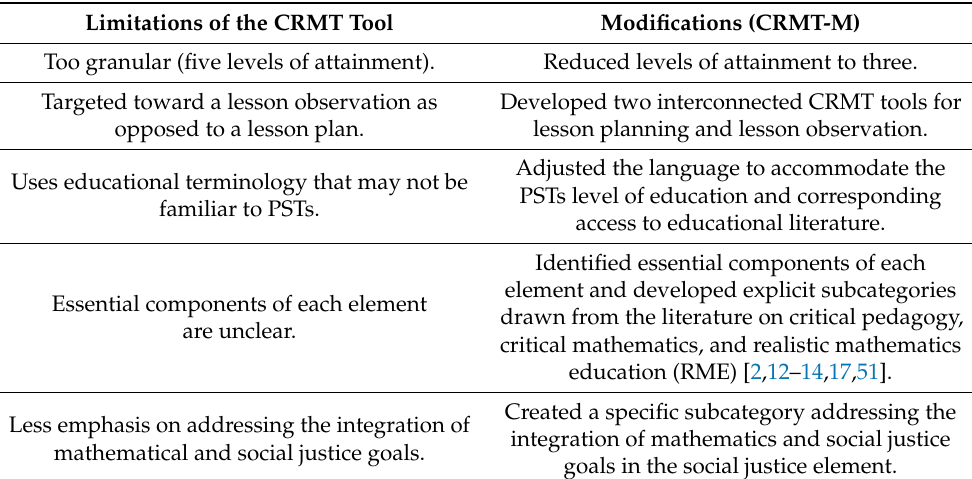
Table 2. Modifications to the CRMT tool